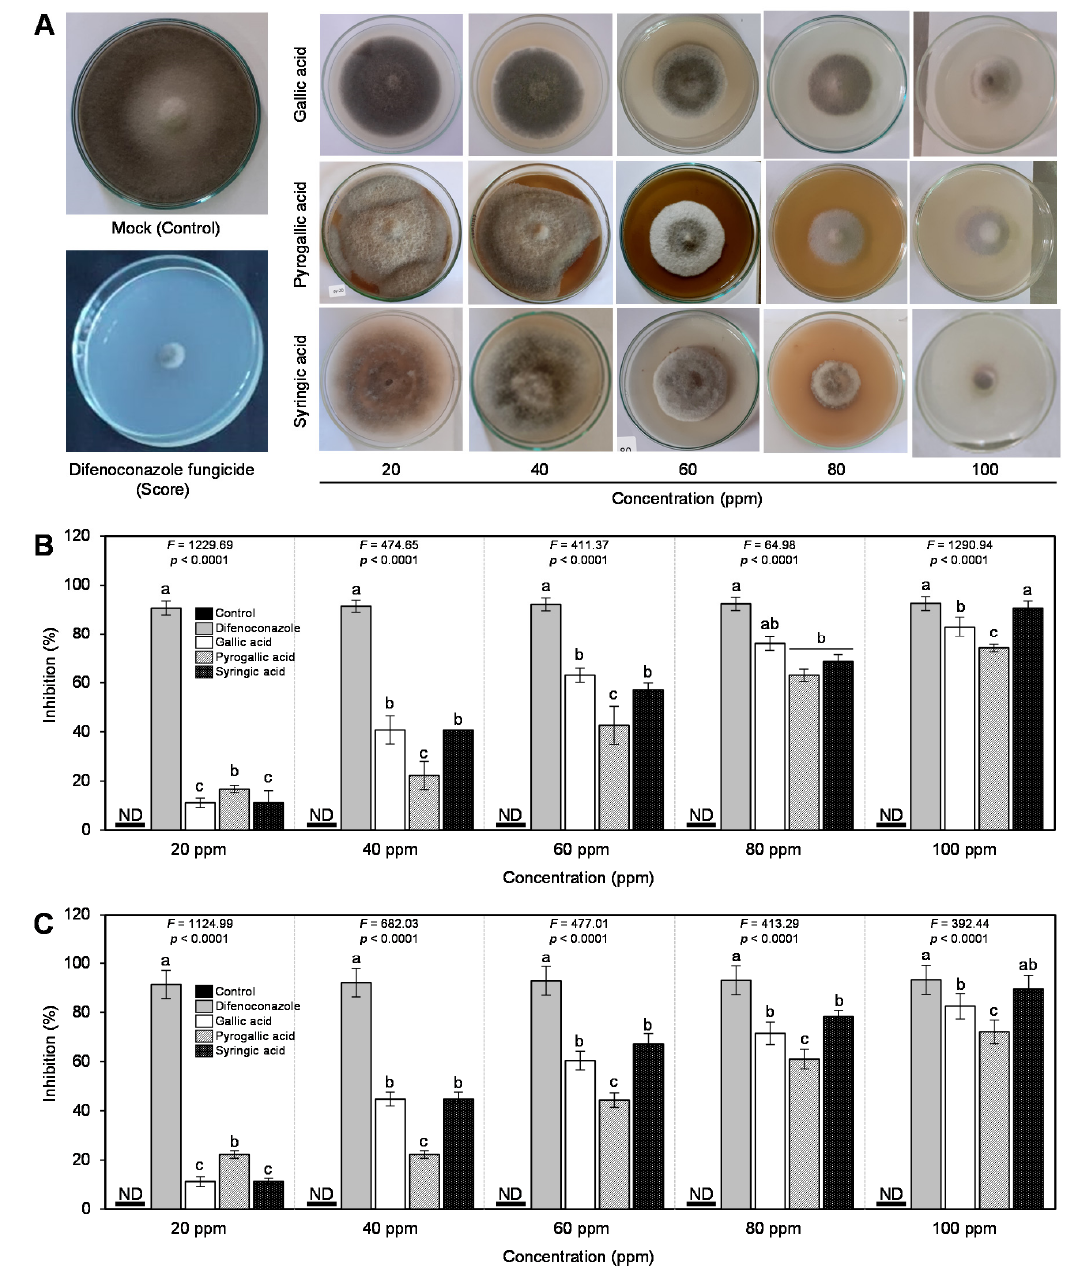
Figure 2. In vitro antifungal activity of gallic acid and its derivatives against A. solani ( n = 6). ( A ) Antifungal activity of di ff erent concentrations (20, 40, 60, 80, or 100 ppm) of gallic acid and its derivatives against the most aggressive isolate of A. solani . ( B , C ) Inhibition (%) of the radial mycelial growth of A. solani after the treatment with di ff erent concentrations of gallic acid and its derivatives (20, 40, 60, 80, or 100 ppm) in petri dish experiments. The experiment was repeated twice with similar results. ND: not detected. Di ff erent letters indicate statistically significant di ff erences among Figure 3. According to slope values, gallic acid (Figure 3B) and its derivatives—pyrogallic acid